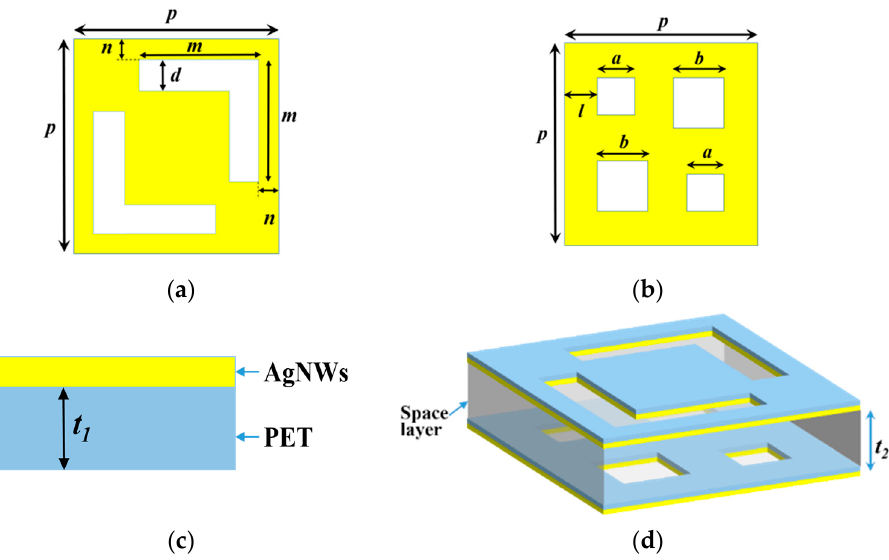
Figure 1. Schematic of the proposed absorber. ( a ) The top patterned silver nanowires (AgNWs) film. ( b ) The bottom patterned AgNWs film. ( c ) Cross-sectional view of the AgNWs film. ( d ) 3D view of the